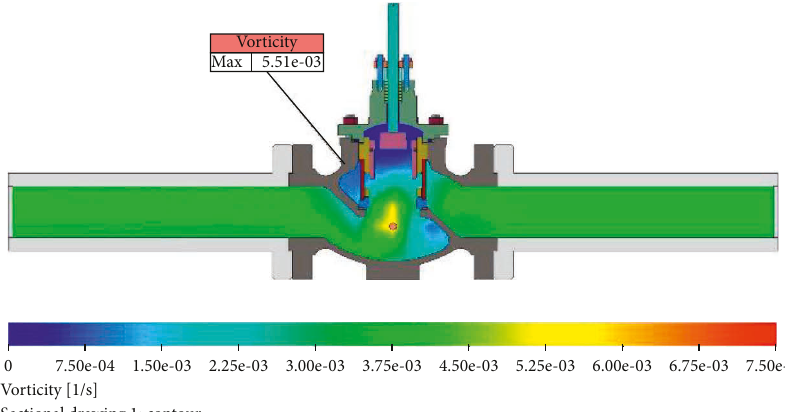
Figure 34: Mach number cloud map for 80% opening.